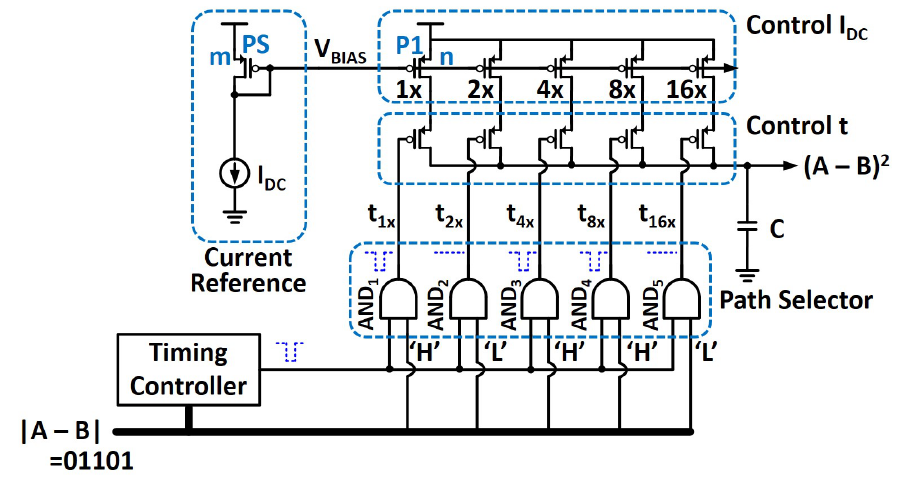
Figure 3. Proposed approximate distance computing unit based on the circuit in Figure